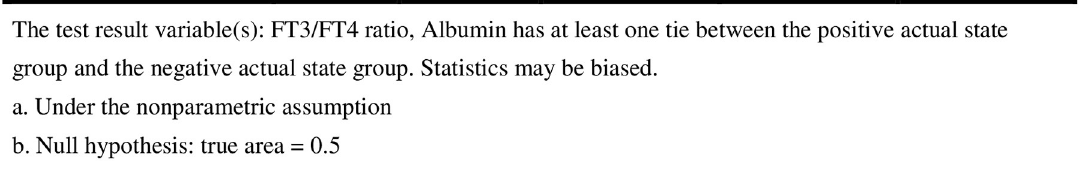
PLOS ONE | https://doi.org/10.1371/journal.pone.0264724 March 14,